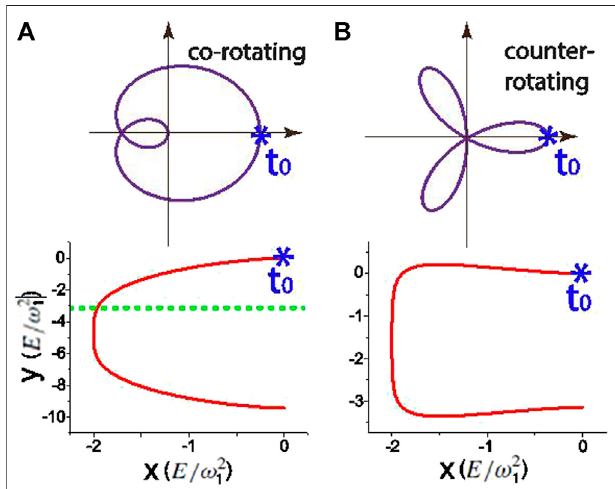
FIGURE7| Bichromatic ( ω 2 (cid:1) 2 ω 1 ) circularlypolarized(toprow)electric fi eld vectors and (bottom row) corresponding laser-induced displacement trajectories [ x ( t ) , y ( t ) ] of free electrons for (A) corotating ( ϵ (cid:1) + 1) and (B) counter-rotating ( ϵ (cid:1) − 1) helicity schemes. The initial position is x ( t 0 ) (cid:1) y ( t 0 ) (cid:1) 0, where t * 0 indicates the ionization time at the maxima of the combined fi elds.Greenlinecorrespondstotheminimumlaser-induced radius r 0 of an ionized electron at frequency ω 1 and circular fi eld amplitude E, r 0 (cid:1) ( 2 E / ω